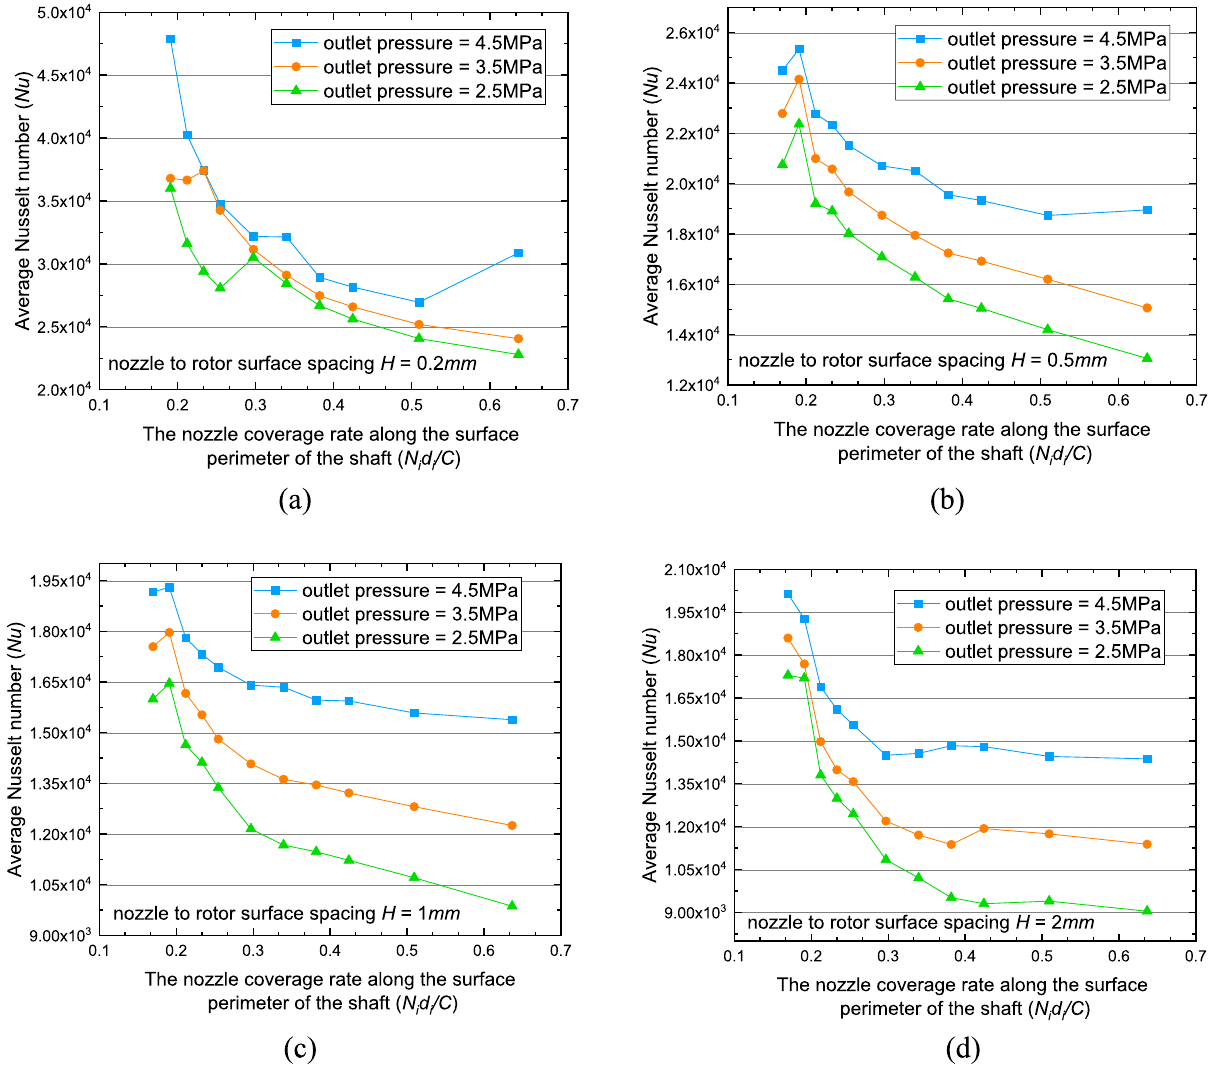
Fig. 5. Variation trend of Nu with N i d i / C , d i =2 mm, q =0.19 kg/s. (a) H / d i = 0.1. (b) H / d i =0.25. (c) H / d i =0.5. (d) H / d i